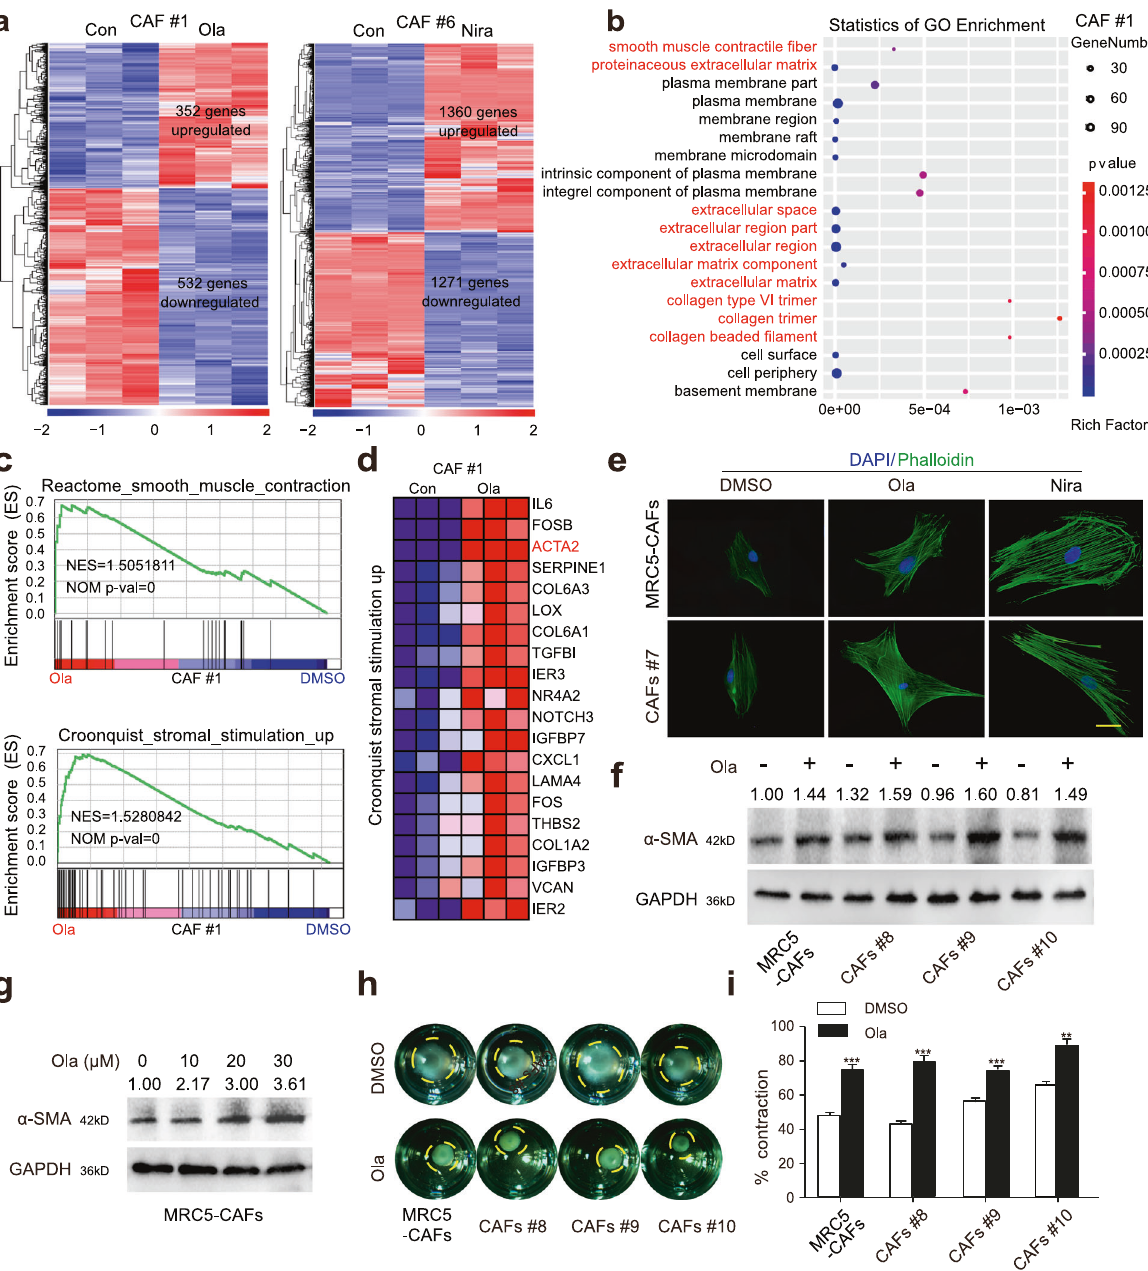
Fig. 2 PARPis promote the activation of OC stromal fi broblasts in vitro. a Hierarchical clustering analysis results of RNA-seq in the PARPi- treated primary CAFs and control groups. b , c Gene ontology (GO) and GSEA showing signi fi cant enrichment for genes encoding ECM processes and signatures representing CAF activation in Ola-treated CAFs. d GSEA-derived heatmap showing the relative mRNA expression of the stroma activation signature genes. e Representative photographs of the cellular cytoskeleton by F-actin staining in MRC5-CAFs and primary CAFs after treatment with PARPis and their corresponding controls. The nuclei were counterstained with DAPI. Scale bar, 10 µm. f , g Immunoblotting of α -SMA in MRC5-CAFs or primary CAFs after 72 h of treatment with Ola. GAPDH served as the loading control. Relative densitometry values are labeled in the photographs. h , i Representative images and quanti fi cation of the collagen contraction capacity of the MRC5-CAFs and the primary CAFs in the control and Ola-treated groups. Data are expressed as mean ± s.e.m., * p < 0.05; ** p < 0.01; *** p <